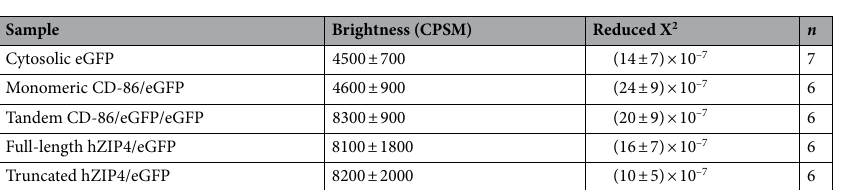
Table 1. Brightness comparison for FCS measurements . Calculated brightness of molecules tagged with eGFP for HEK293 cells expressed cytosolic, membrane-bound monomeric eGFP control, membrane-bound dimeric eGFP control, full-length hZIP4/eGFP, and truncated hZIP4/eGFP protein, respectively. Brightness values are reported as counts per second per molecule (CPSM). X 2 refers to the goodness of fit of the data to the two-component model. Data represent the mean ± the standard error of the mean for the number of cells examined (n).